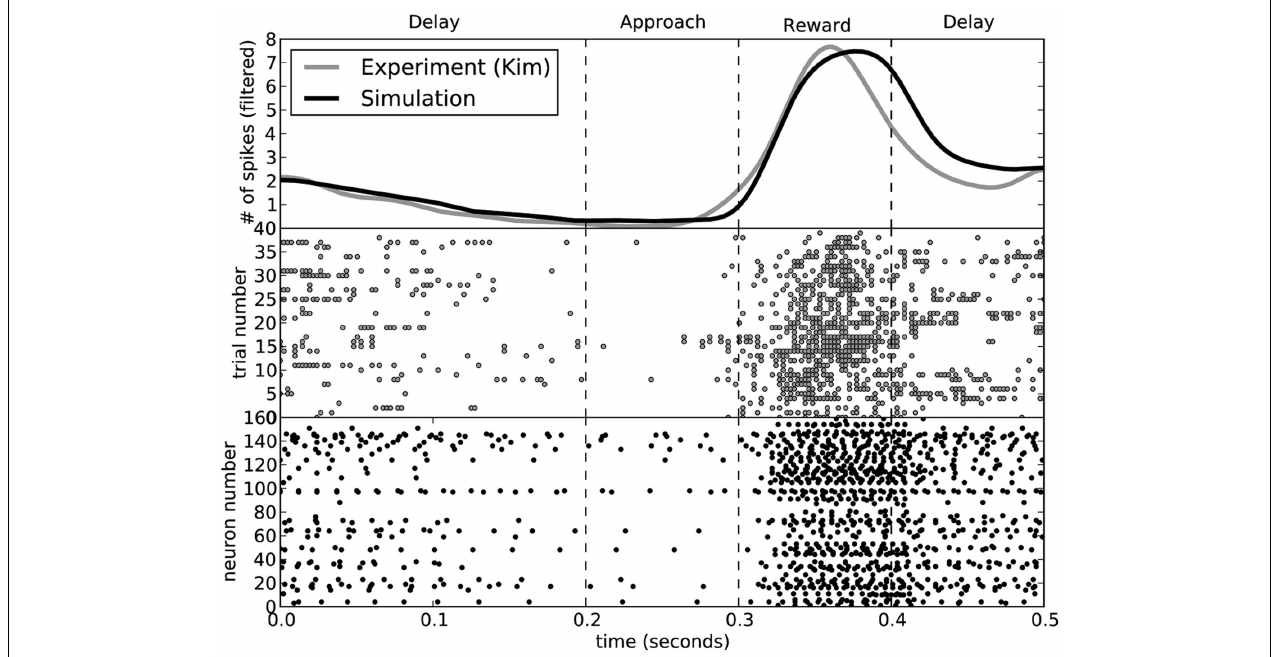
FIGURE 8 |A comparison of spike patterns in the ventral striatum of the rat (from Kim et al.’s, 2009) and our model. The top area shows spike counts, with a Gaussian filter of 15ms. All data is from runs where the rat (or model) turned to the left.